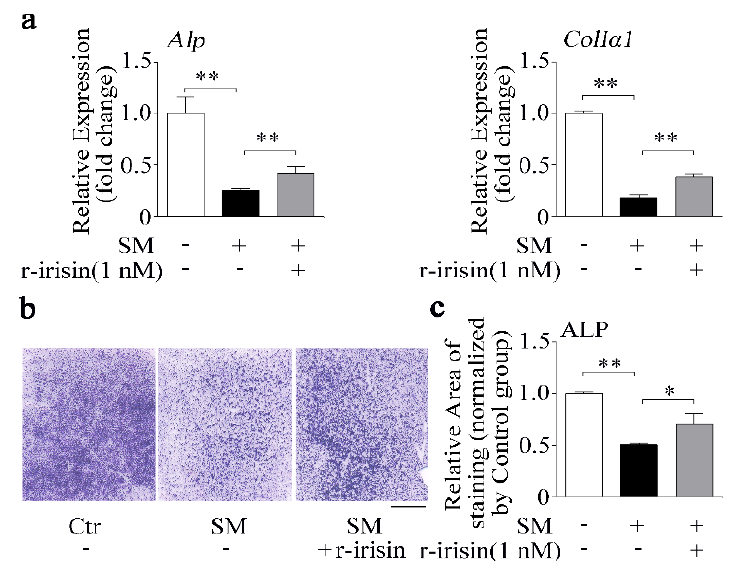
Figure 4. r ‐ Irisin in part prevents the decrease of osteoblast differentiation induced by simulated microgravity. ( a ) Real ‐ time PCR analysis of Alp and ColI α 1 in primary osteoblasts after treatment with either 1 nM r ‐ irisin or PBS for 48 h under simulated microgravity; n = 3. ( b ) Representative images of ALP staining of primary osteoblasts after treatment with either 1 nM r ‐ irisin or PBS for 48 h under simulated microgravity. Scale bar, 5 mm. ( c ) Quantification of staining areas in primary osteoblasts after treatment with either 1 nM r ‐ irisin or PBS for 48 h under simulated microgravity; n = 3. Gapdh was used as the internal control for mRNA. Ctr: control; SM: simulated microgravity. All data are the mean ± SD. Statistical differences between the two groups were determined by the Student’s t ‐ test; * p < 0.05, ** p < 0.01.